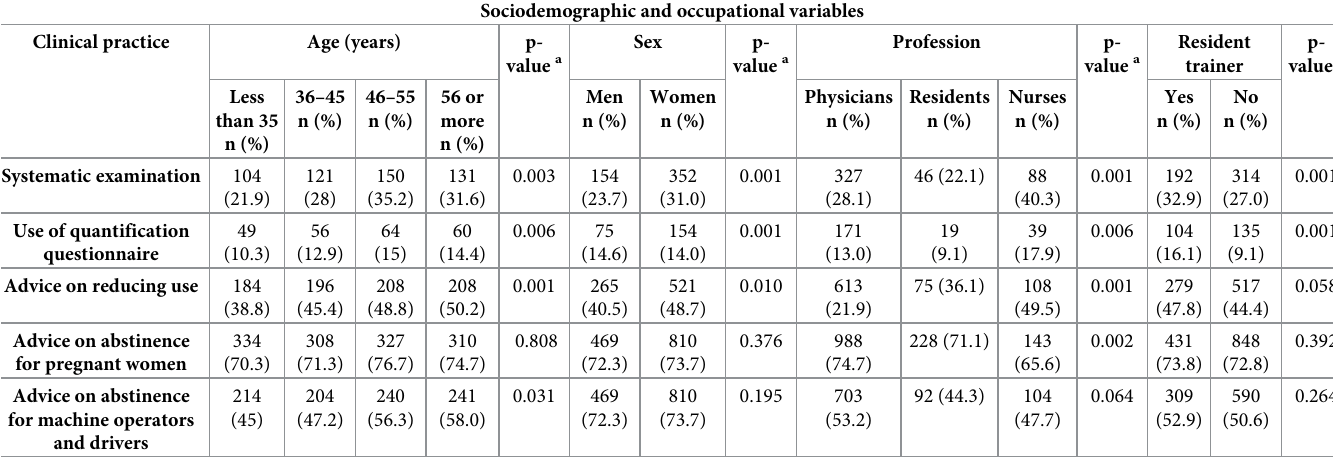
Table 5. Practice of PC professionals in their approach to alcohol according to sociodemographic and occupational